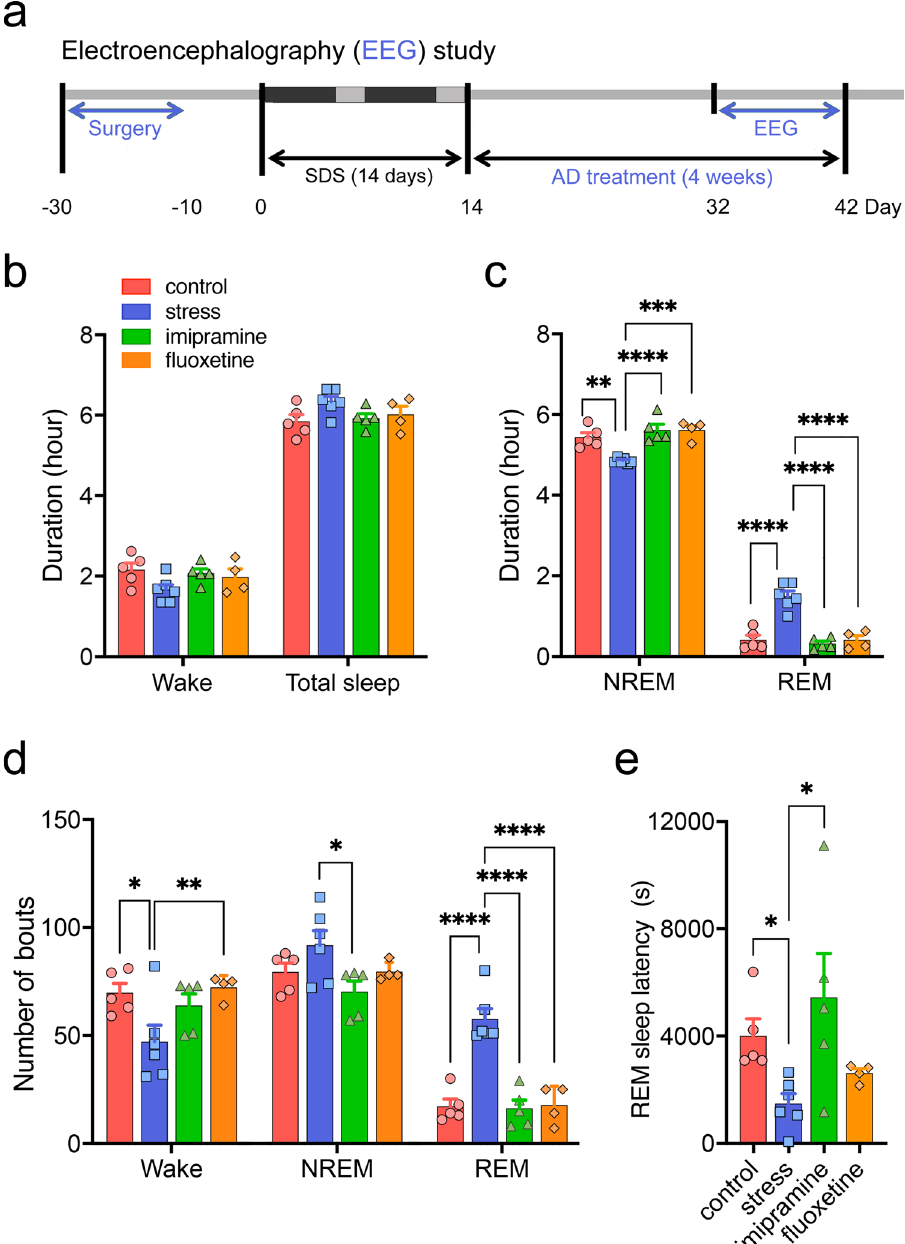
Figure 3. Effects of social defeat stress (SDS) and chronic antidepressant (AD) treatment on sleep architecture. ( a ) Experimental schedule for sleep analysis. ( b ) Durations of wakefulness and total sleep during the light phase (8:00 [ZT0]–16:30 [ZT8.5]) at 1 month after the last SDS. ZT; zeitgeber time. ( c ) Total durations of non-rapid eye movement (NREM) and rapid eye movement (REM) sleep during the light phase. F (3, 32) = 41.55, p < 0.0001, ** p < 0.005, *** p < 0.0005, **** p < 0.0001, two-way (group x sleep stage) repeated analysis of variance (ANOVA) with Tukey’s multiple-comparisons test. n = 4–6/group. ( d ) Total number of bouts of NREM and REM sleep, as well as wakefulness during the light phase (ZT0–ZT8.5). F (6, 48) = 10.06, p < 0.0001, * p < 0.05, ** p < 0.01, **** p < 0.0001, two-way ANOVA with Tukey’s multiple-comparisons test. n = 4–6/group. ( e ) REM sleep latency. p = 0.0092, * p < 0.05, Kruskal–Wallis test followed by Dunn’s multiple comparisons test. n =